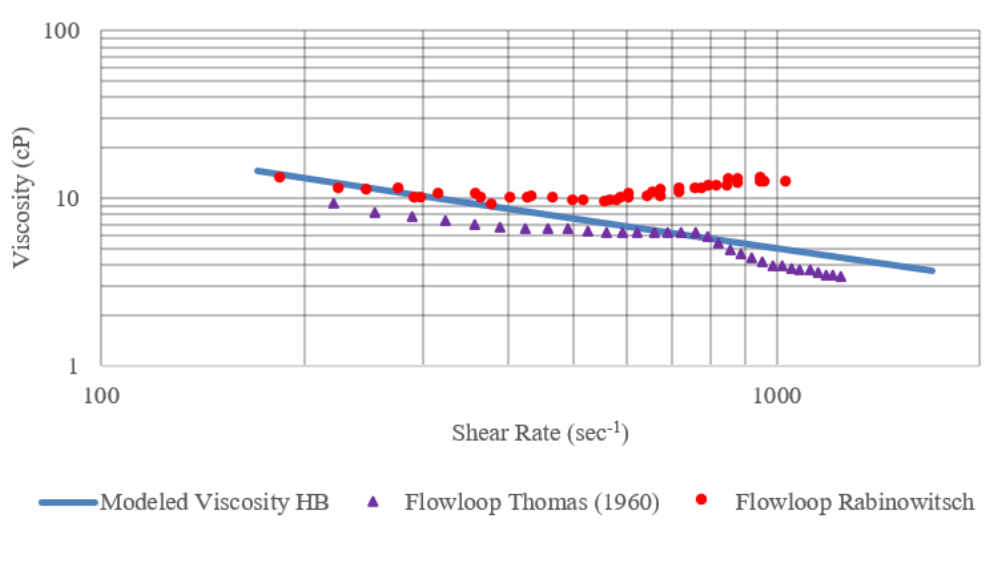
Figure 6: Estimated viscosity of Formulation